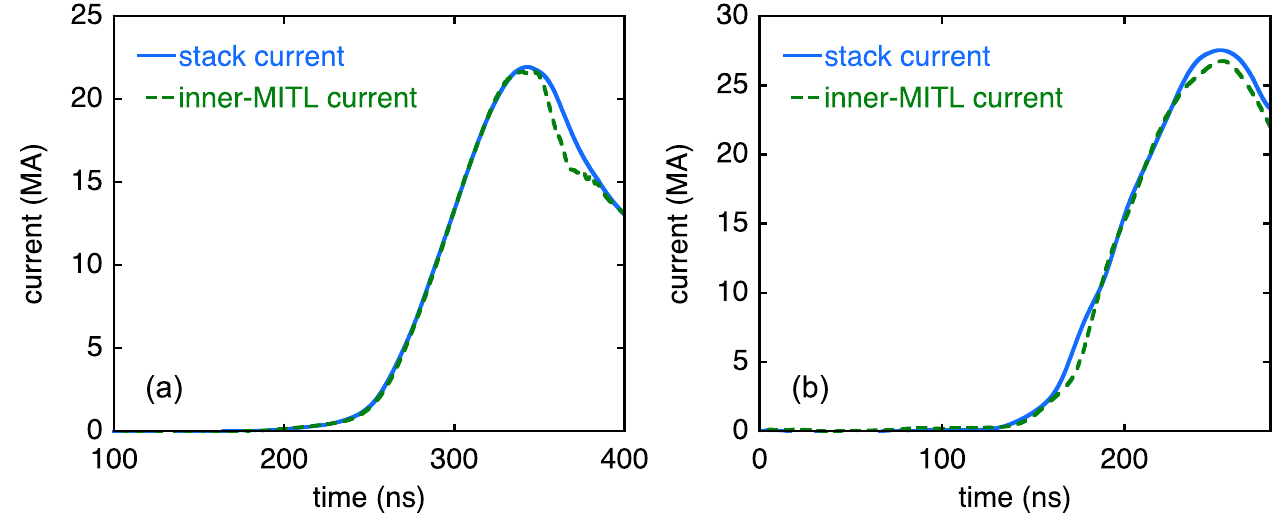
FIG. 13. (a) Measured insulator-stack and inner-MITL currents for Z-shot 1548 [37]. The load on this shot was a dynamic hohlraum. The inner-MITL current was measured 6 cm from the symmetry axis of the load. (b) Measured insulator-stack and inner-MITL currents for ZR-shot 2759, which also drove a dynamic hohlraum. The inner-MITL current was measured at the same distance from the symmetry axis.